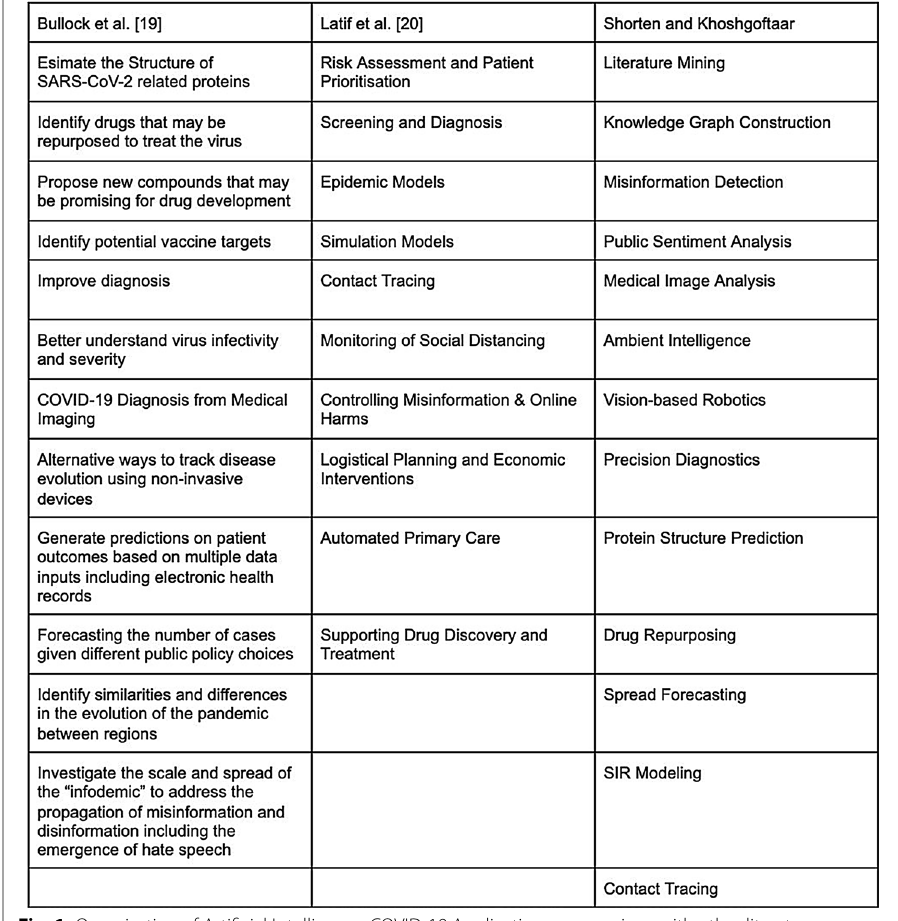
Fig. 1 Organization of Artificial Intelligence COVID-19 Applications, comparison with other literature